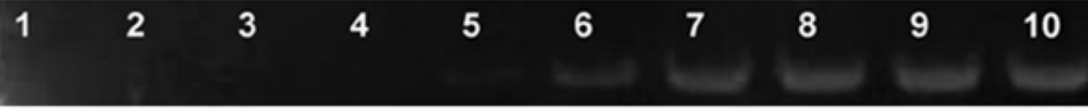
Figure 25. Agarose gel electrophoresis of 17 -based SLNs incubated with increasing concentrations of plasmid DNA (values are expressed in mg mL − 1 )